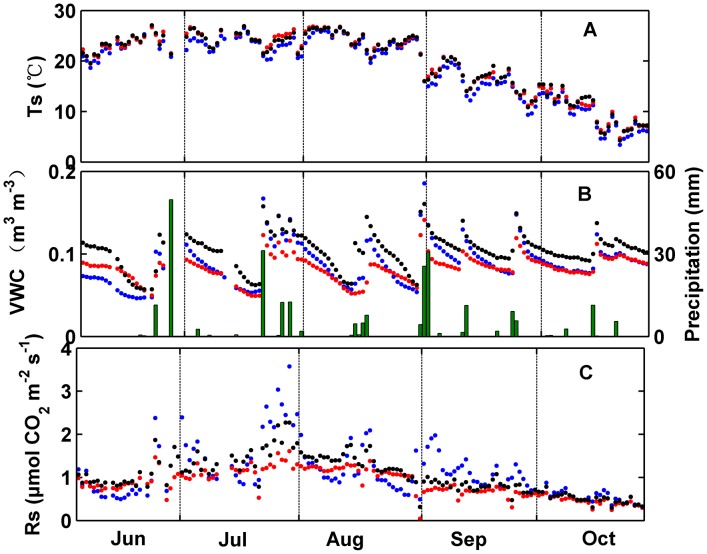
Daily mean of soil respiration (Rs), soil temperature (Ts), and soil volumetric water content (VWC) in soil crusted with algae (red), lichen (black), and moss (blue).